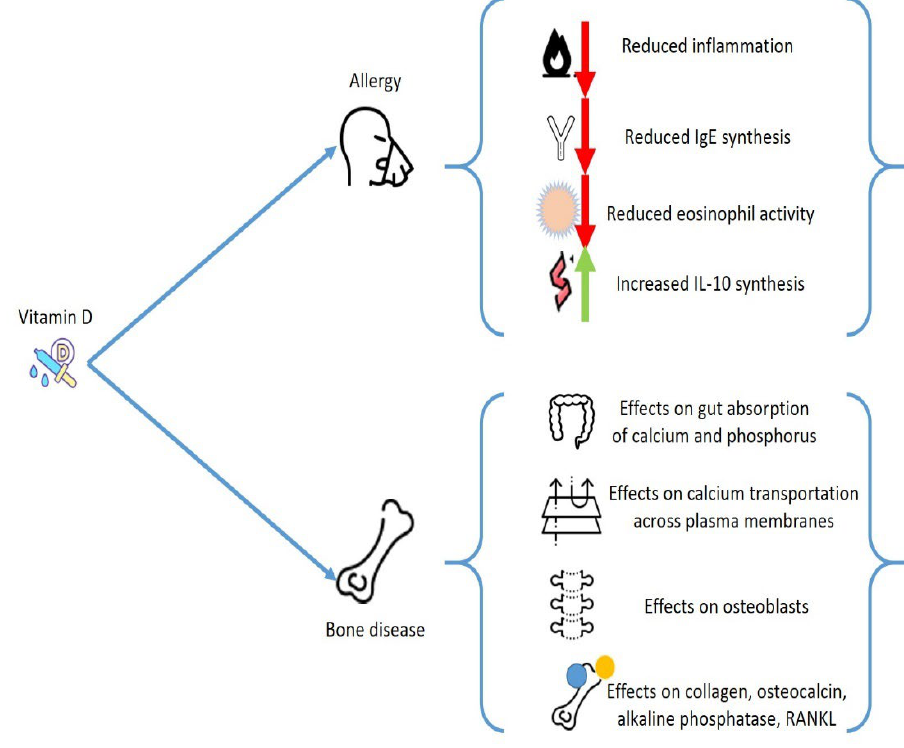
Figure 1. Possible effects of vitamin D on the onset of allergic diseases and on bone metabolism.